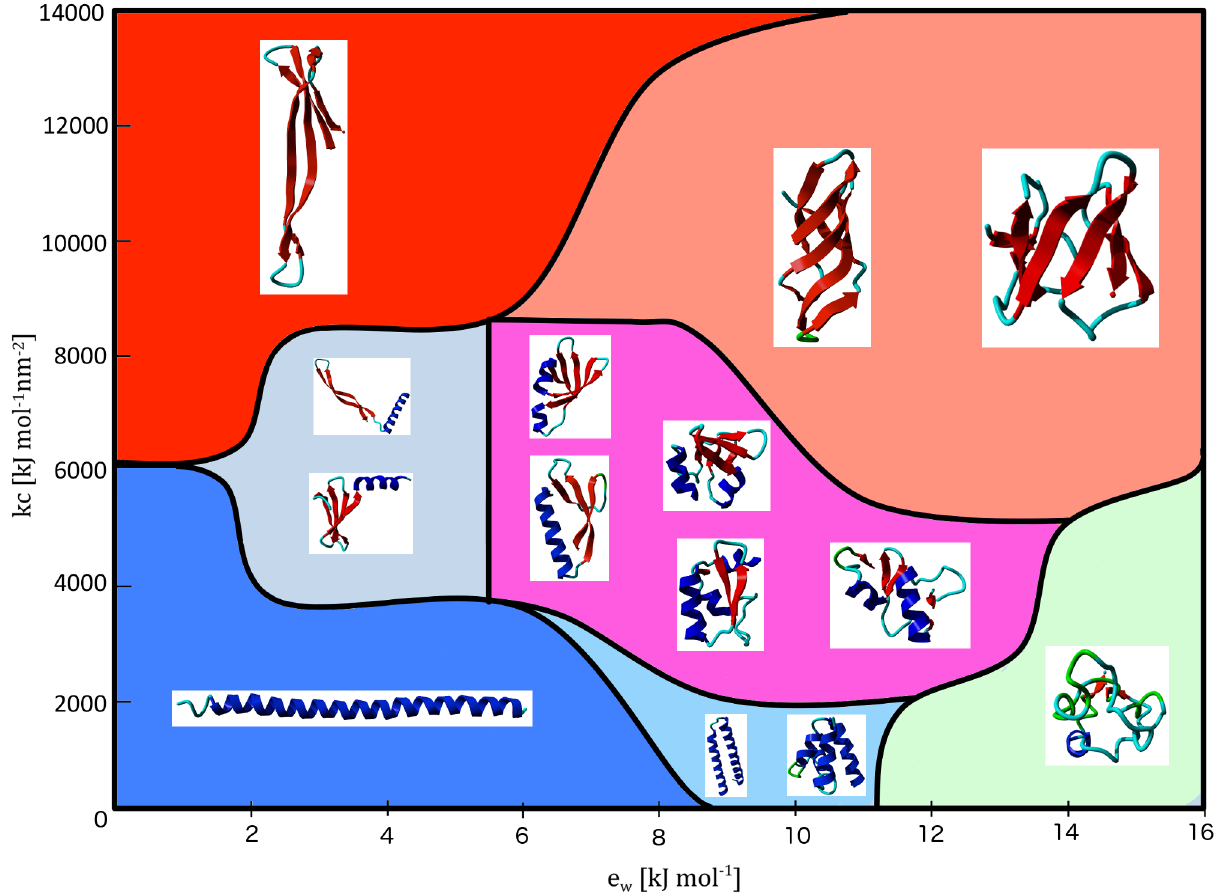
Fig 1. Phase diagram of Val60 in the CamTube force field. The phase diagram is shown as a function of the hydrophobic energy, ε W , and the curvature, κ c , parameters. Representative structures in each region of the parameter space are shown as